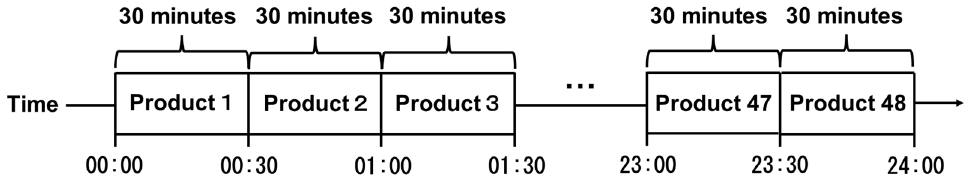
Figure 4. A total of 48 products of 30-min periods in electricity markets.